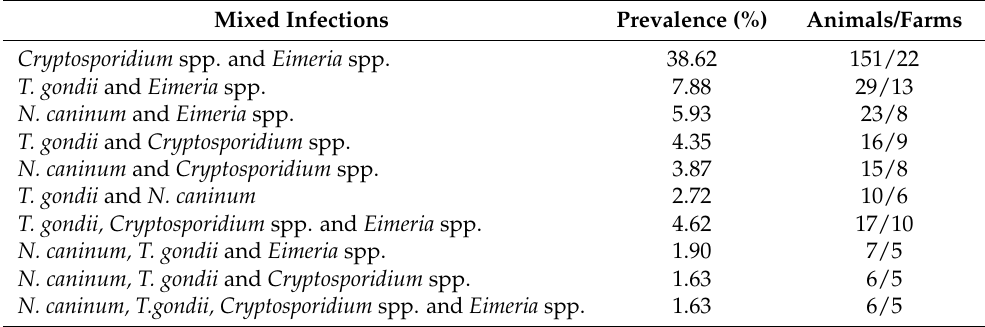
Table 2. Prevalence of mixed infections with Neospora caninum, Toxoplasma gondii, Cryptosporidium spp. and Eimeria spp. in sampled goats from canton Zapotillo, Ecuador.